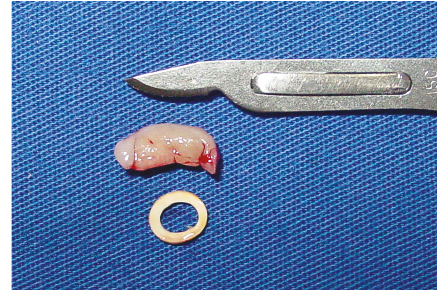
Figure 6: The elastic band and the tissue removed.